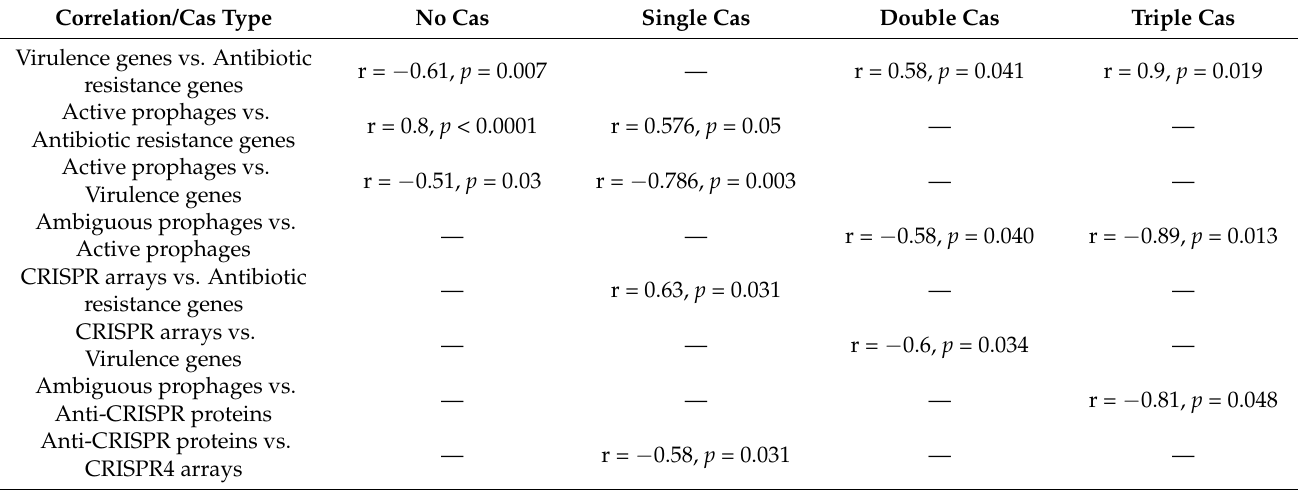
Table 2. Significant correlations in the analyzed groups of CriePir P. aeruginosa